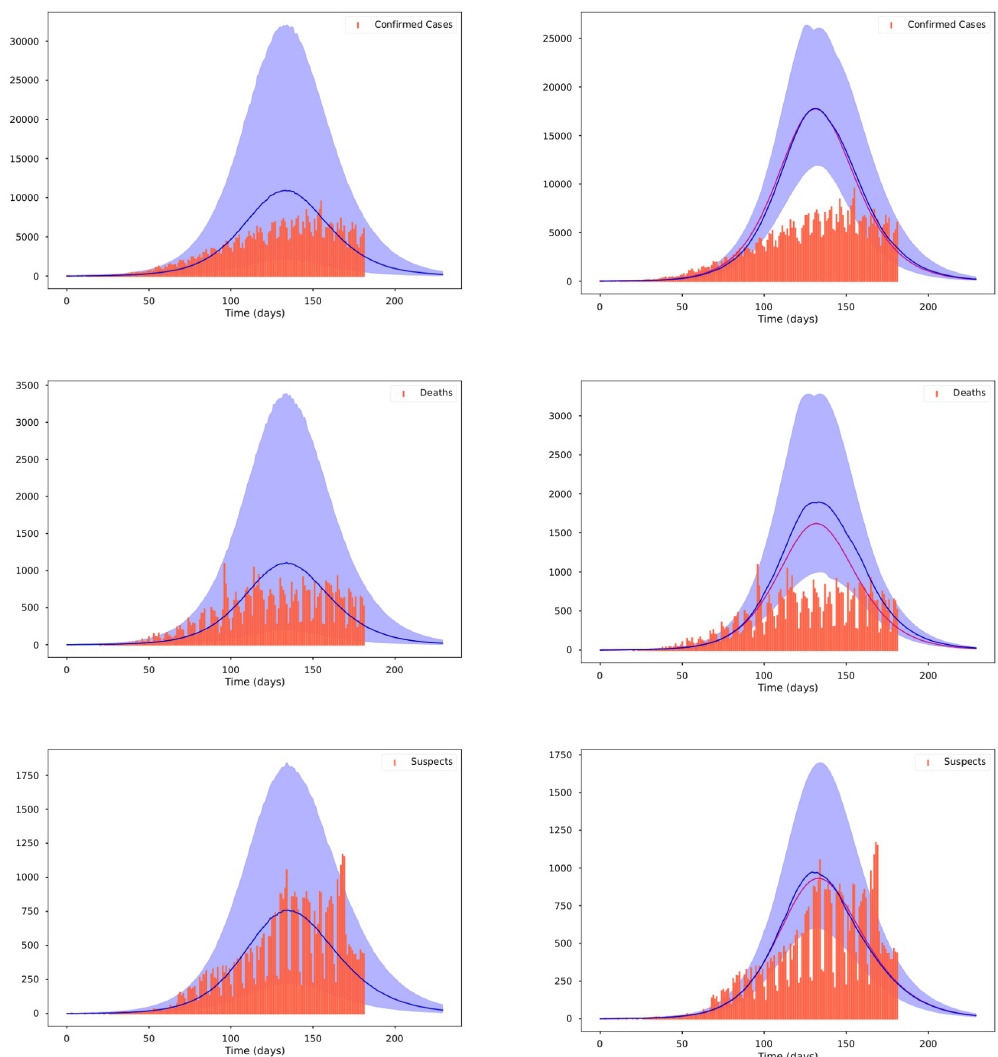
Fig 2. Incidence analysis for Mexico considering data for the first 182 days of the pandemic (until 6 August 2020). Left column corresponds to the inference analysis using the Stan Package. Right column corresponds to the inference analysis using the t- walk Package. Row from top to bottom correspond to the confirmed cases, deceases and suspects. Posterior uncertainty is illustrated with the blue shadow areas within the 95% Highest-Posterior Density. Red bars correspond to the data, i.e., the confirmed cases, deceases and suspects. Blue line denotes the median, and the purple line on the right column correspond to the mode. very similar results. Fig 4 and the right-hand column of Fig 2 show corresponding results using the t- walk package (the Python version). Fig 4 shows the credible intervals for the esti- mated parameters of model (1) within %95 of HPD using the t- walk Package [64]. Top row from left to right, the parameters: β , β , ρ . Middle row from left to right: γ , σ , q . Middle row s a from left to right: E , A , I . Bottom row from left to right: ϕ , ϕ , ϕ I performed 600000 itera- 0 0 0 0 1 2 tions with 300000 of them as burn-in. Using both packages, I have made predictions until the day 240, meaning 16 October. Future work will analyze the identifiability of the parameters of model (1), as suggested in [59, 66, 67], specifically the ρ parameter, because this parameter is multiplied by the period of incubation of the disease, α . Thus, estimating both parameters